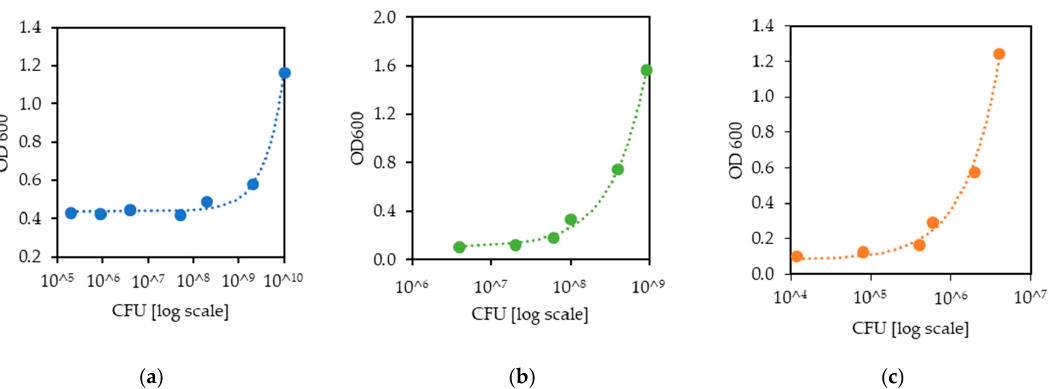
Figure 1. Correlation between OD 600 and cell number for ( a ) L. lactis , for which the regression equation is OD 600 = 7.257 × 10 11 CFU + 0.436, where the R 2 is 0.995; ( b ) B. subtilis , for which the regression equation is OD 600 = 1.622 × 10 9 CFU + 0.104, where the R 2 is 0.997; ( c ) and S. cerevisiae , for which the regression equation is OD 600 = 5.629 × 10 8 CFU + 0.082, where the R 2 is 0.991.